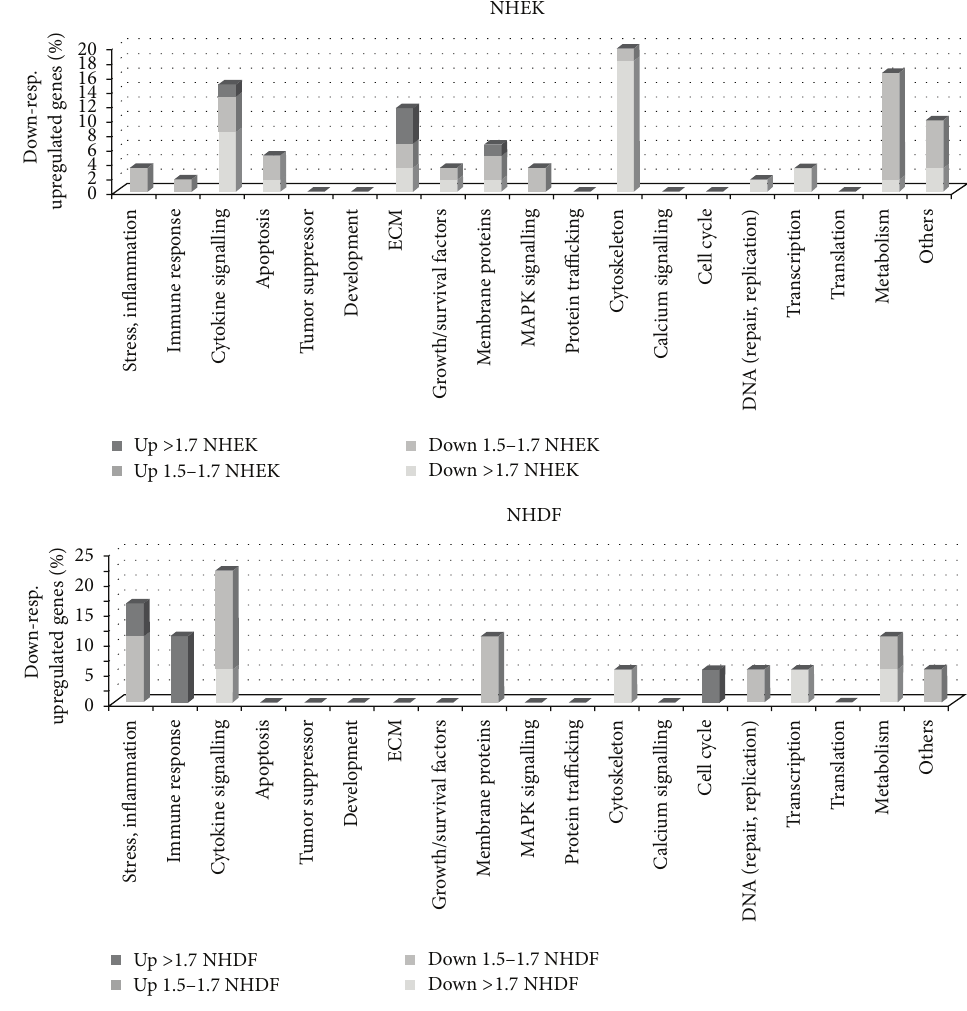
Figure 8: Genes regulated in NHEK, respectively, NHDF determined with the topic-defined PIQOR skin microarray after incubation of cells with 10 𝜇 g/mL TSw for 6 h. Presented is the ratio of regulated genes in percent in regard to the total number of regulated genes. The amount of not regulated genes is not presented. The minimal fold change is significant if the ratio is >